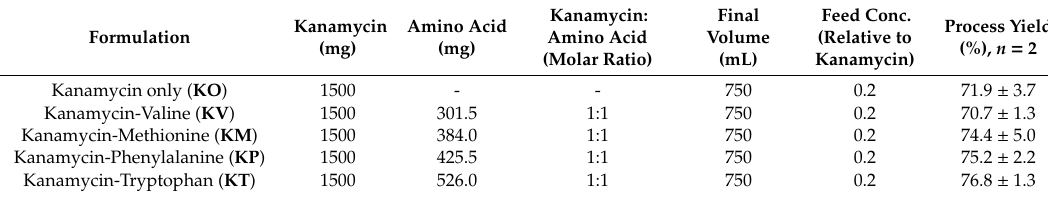
Table 1. Preparation and process yield of the various spray-dried particles. Values are expressed as mean ± standard